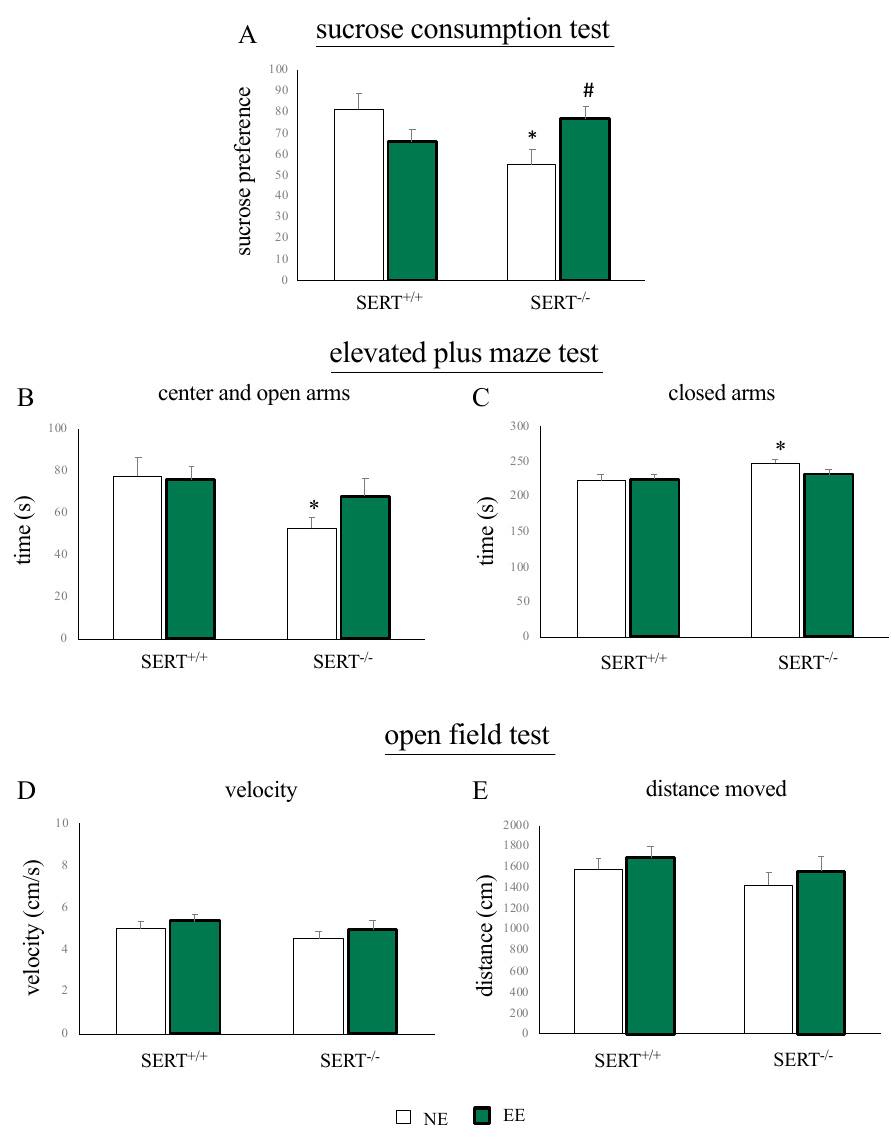
Figure 2. Behavioral characterization of SERT +/+ and SERT − / − rats subjected to one month of exposure to NE (normal environment) or EE (environmental enrichment). ( A ) Sucrose preference in the sucrose consumption test. ( B ) Time spent in the center and in the open arms ( C ) and in the closed arms during the EPM test. ( D ) Velocity in the open field test. ( E ) Distance moved in the open field test. The data are presented as mean ± standard error of the mean (SEM). * p < 0.05 vs. SERT +/+ /NE; # p < 0.05 vs. SERT − / − /NE; two-way analysis of variance (ANOVA) followed by protected least significant difference (PLSD).